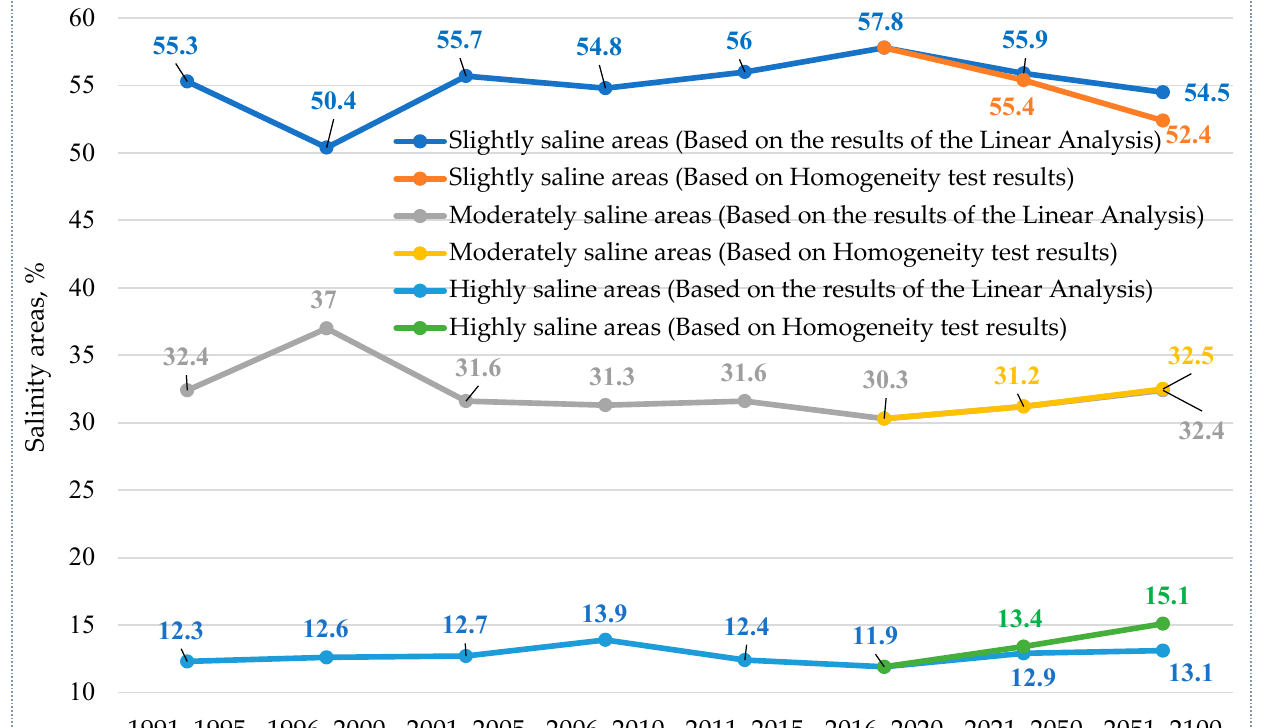
Figure 5. Projection of salinity areas.